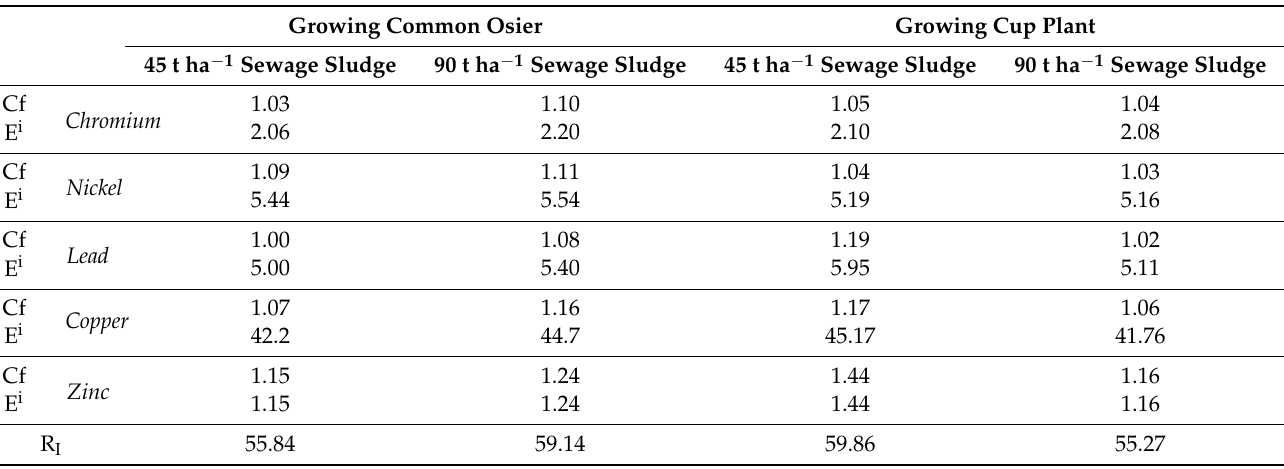
Table 5. Metal contaminant factors (Cf) and potential ecological risk index (R I ) of heavy metals in soils contaminated by sewage sludge. Growing Common Osier Growing Cup